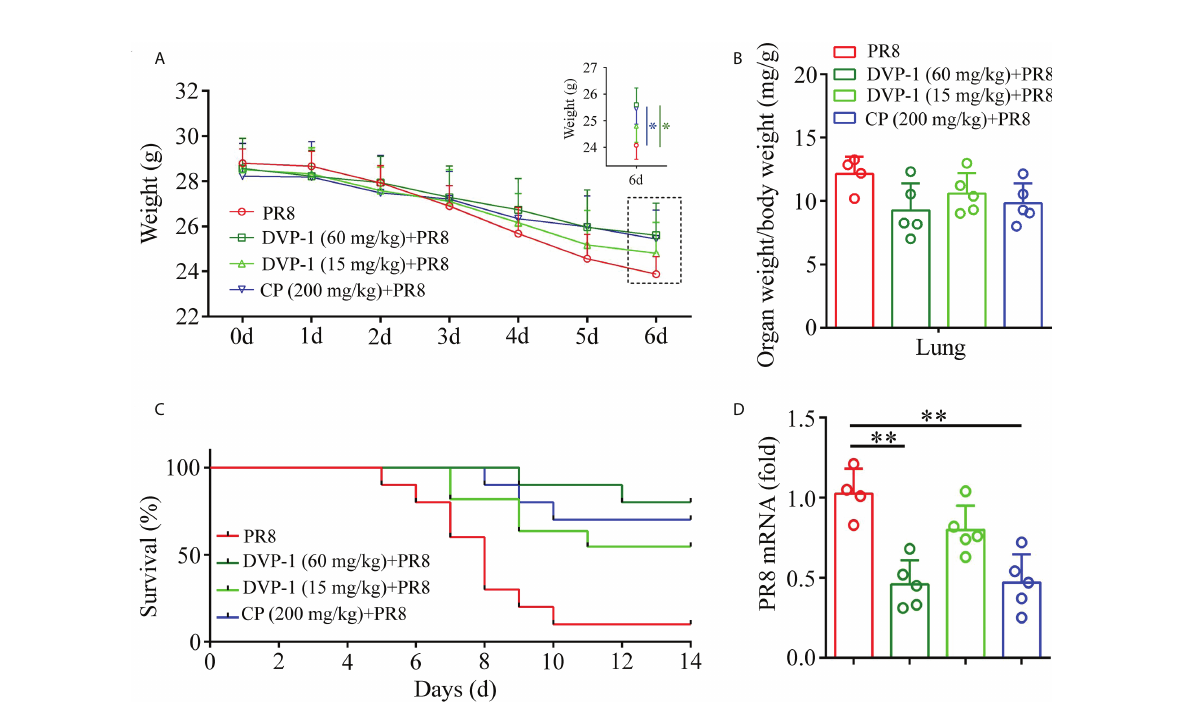
FIGURE 4 Determination of related indices in mice after virus infection of PR8. (A) Body weight change in BALB/c mice. (B) Organ index of lung tissue on the 6th day. (C) Survival rate of mice within 14 days. (D) Virus content in lung tissue on the 6th day. *p < 0.05, **p < 0.01.